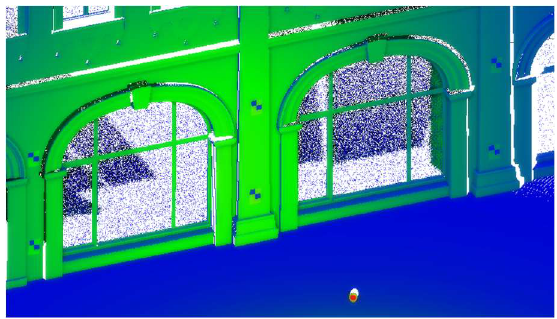
Figure 5. Example of point cloud, generated by the simulator. Figure 5 represents an example of point cloud, generated by the simulator. The spherical and checkerboard targets are clearly distinguishable in the simulated point cloud, also different intensity values can be observed. Since laser beam propagation through glass is also simulated, some points are visible inside the building, behind the window.